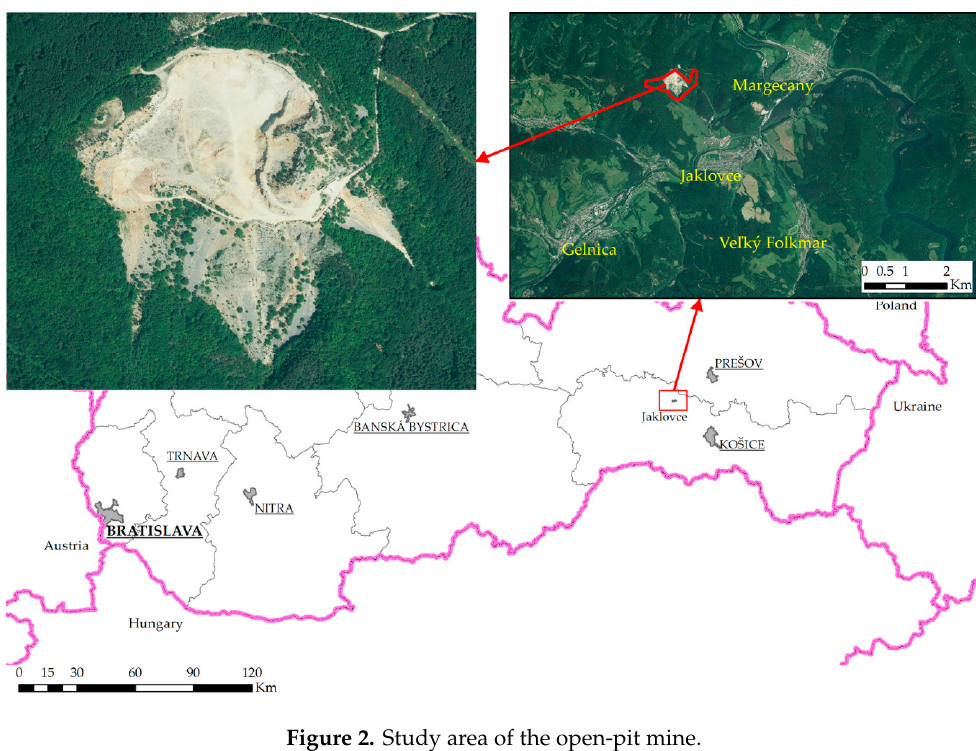
Figure 2. Study area of the open-pit mine.